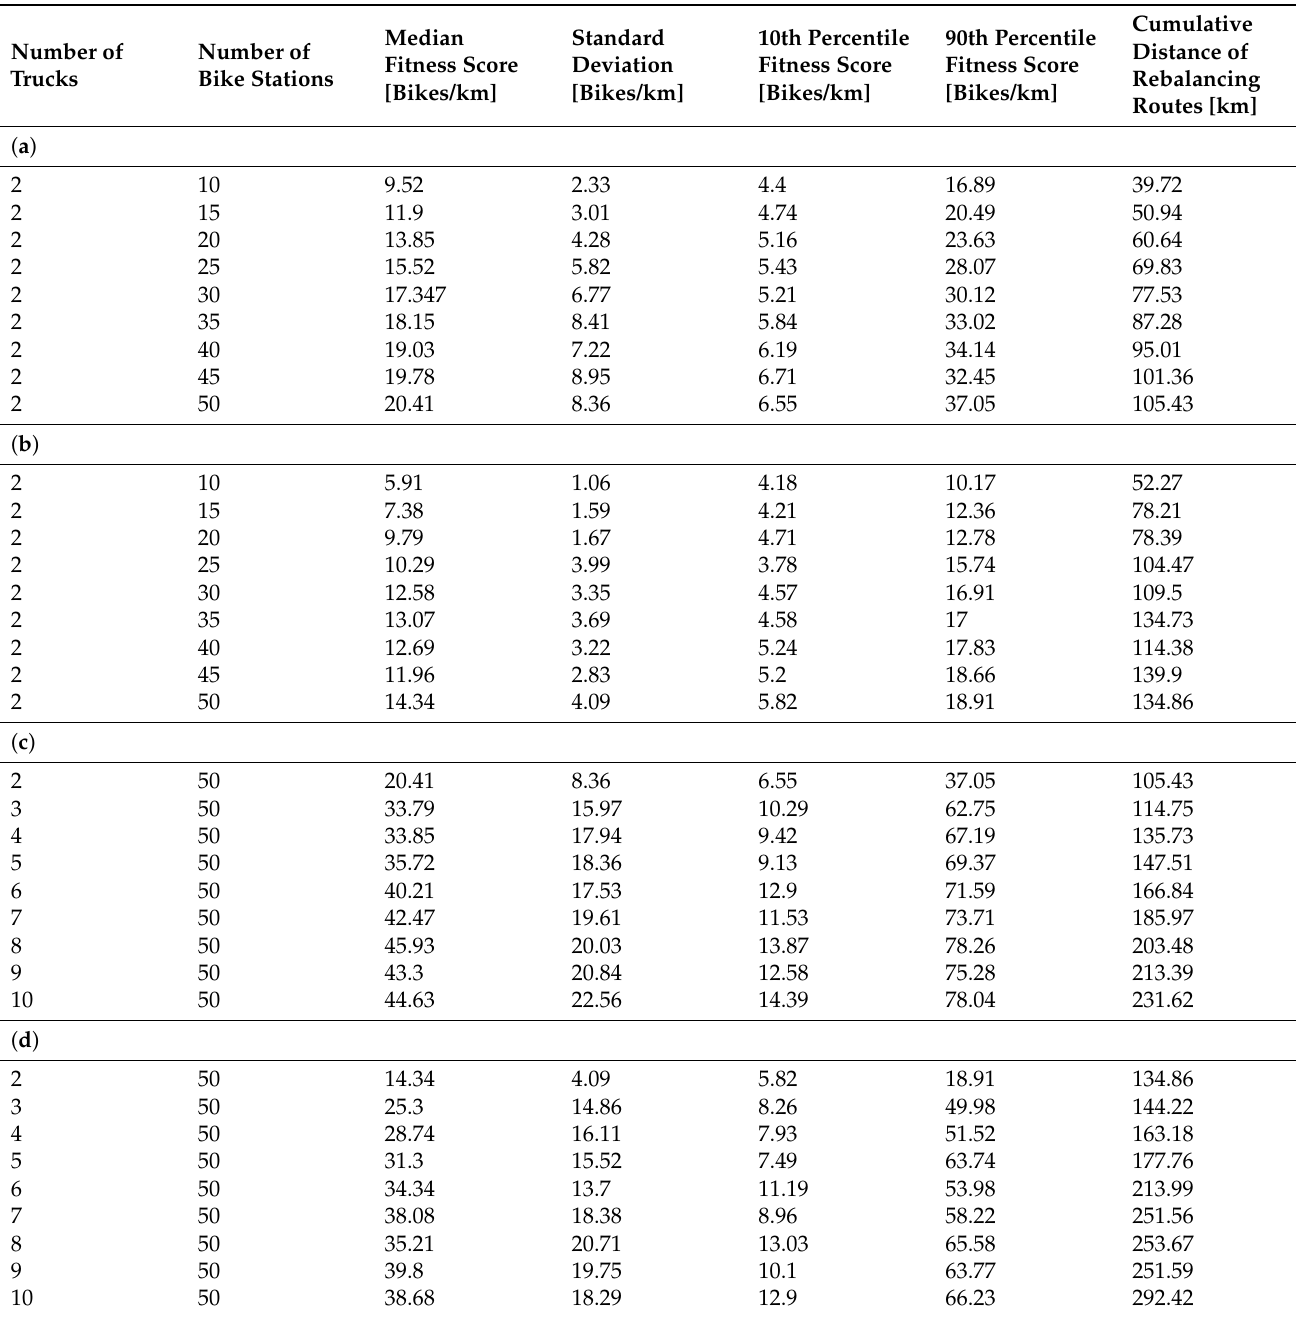
Table 6. ( a ) Performance of the FLCGA for different numbers of bike stations to rebalance. ( b ) Performance of the ACO for different numbers of bike stations to rebalance. ( c ) Performance of the FLCGA for different numbers of rebalancing trucks. ( d ) Performance of the ACO for different numbers of rebalancing